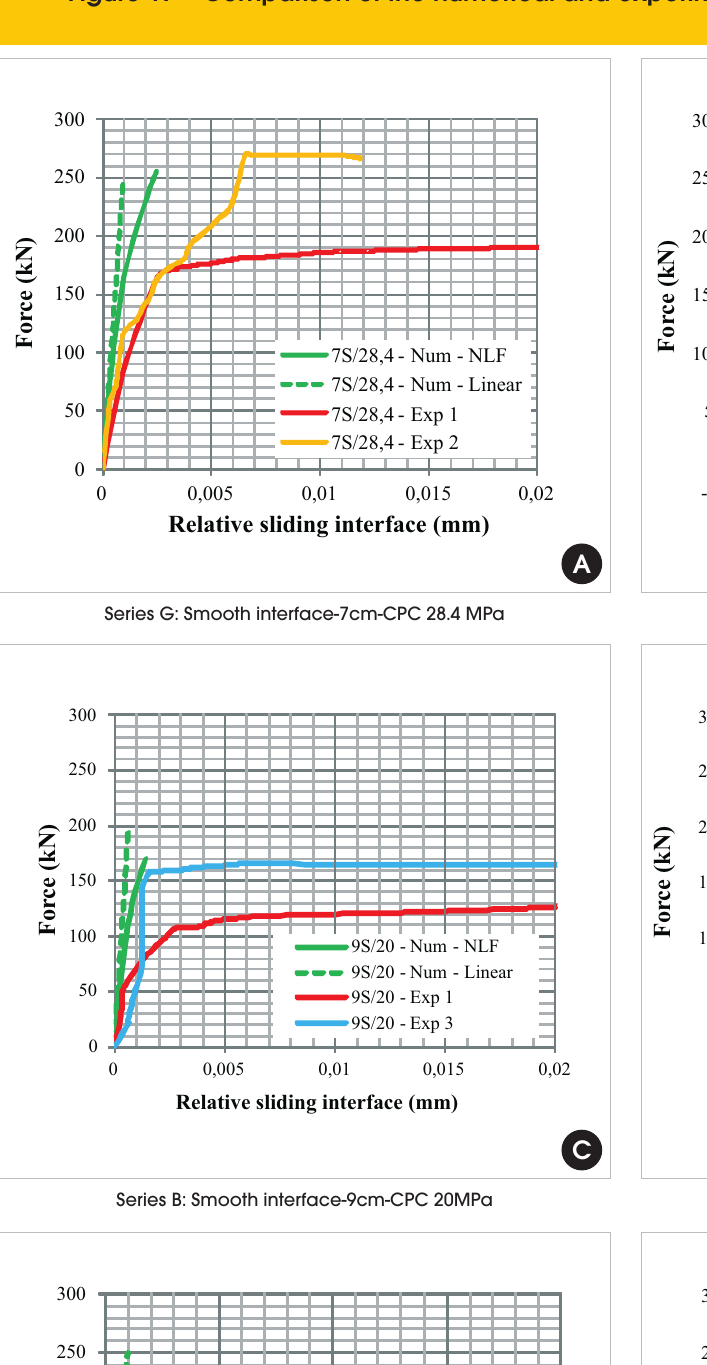
Figure 17 – Comparison of the numerical and experimental results for Series B, D, E, F, G and